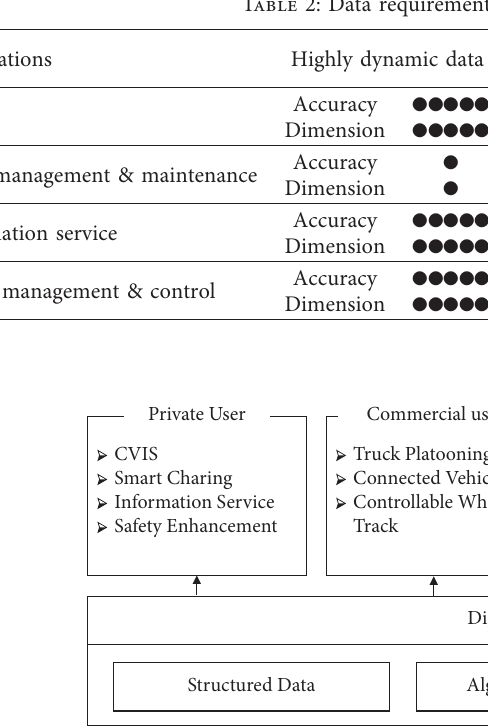
Figure 7: Applications architecture of the NGSH.